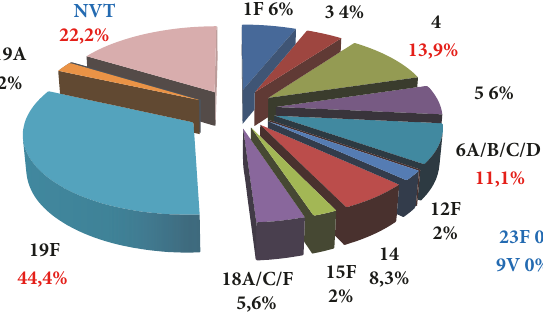
Figure 3: Serological variants of S. pneumoniae 1 year after vaccination with PCV-13 in the examined group (Khabarovsk Territory,